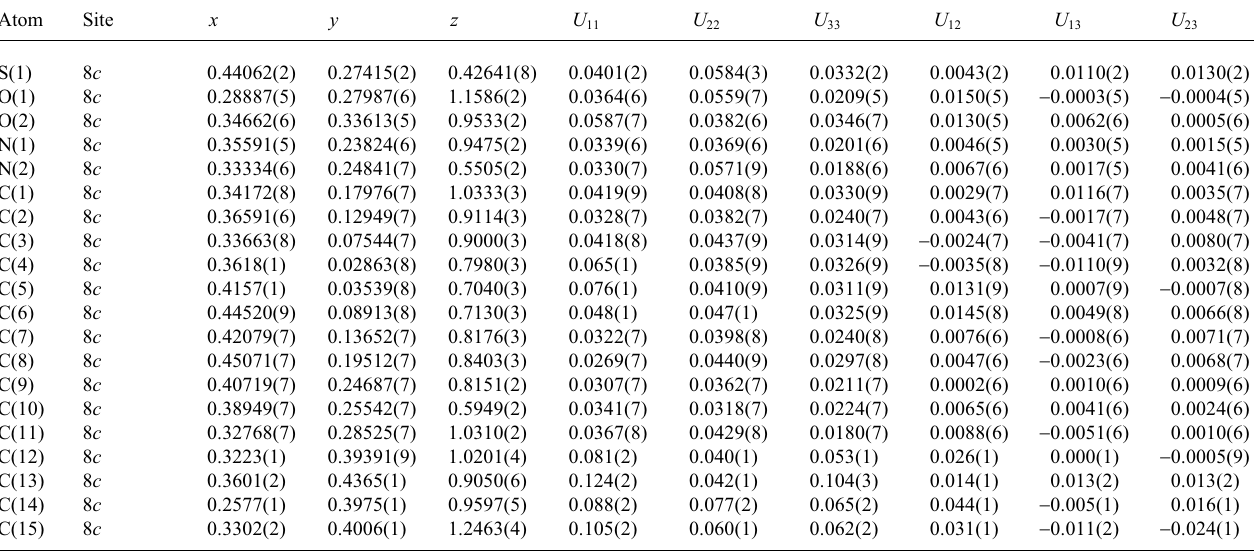
Table 3. Atomic coordinates and displacement parameters (in Å 2 )